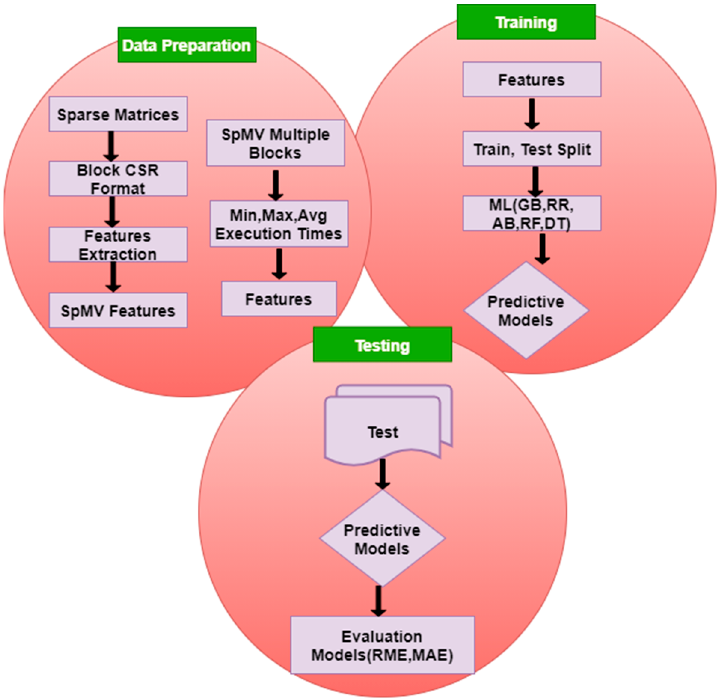
Figure 1. Data Preparation, training, and testing phases.